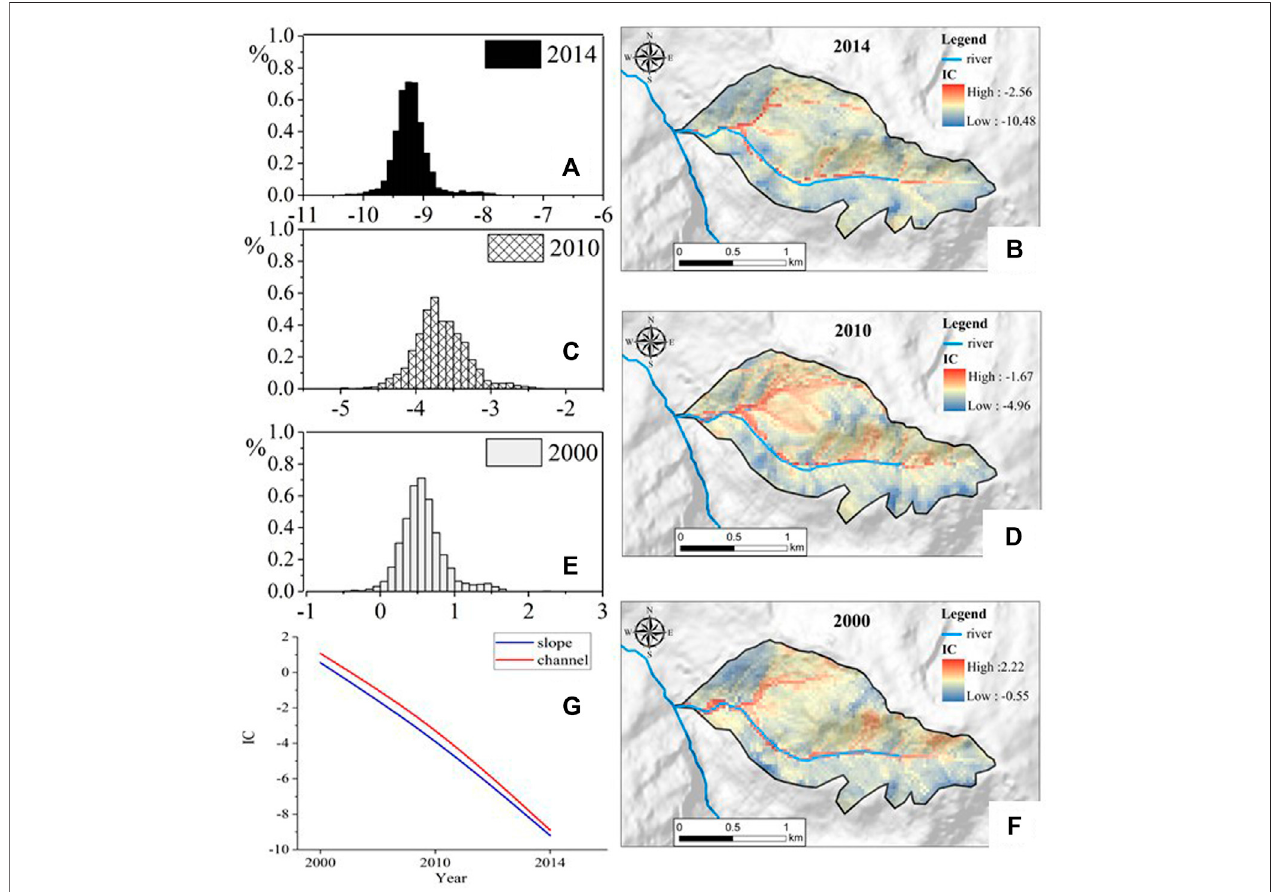
FIGURE 11 | Distribution of the IC values in tributary 1 near the